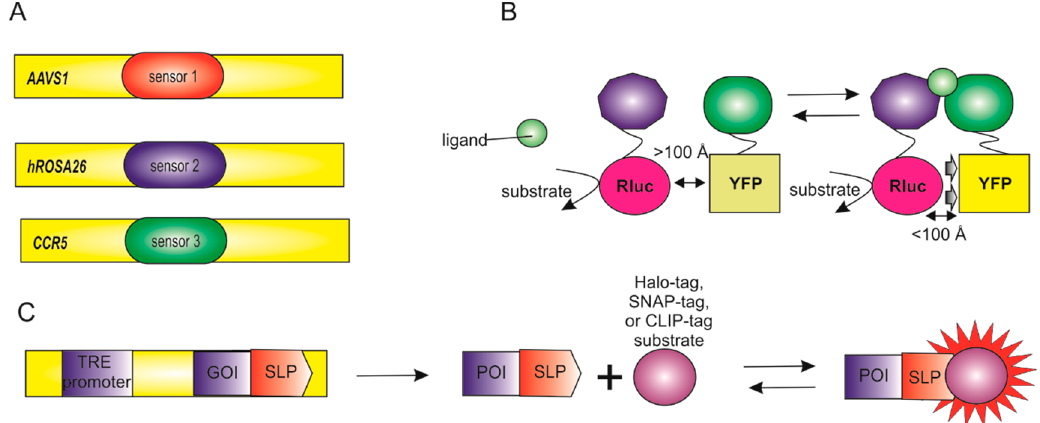
Figure 4. Combination of biosensors. ( A ) Combination of several biosensors at different safe-harbor loci. ( B ) Combination of different biosensors types, for example, chemiluminescent protein and the fluorescent protein. BRET. ( C ) Combination of organic dyes and a genetically encoded protein. SNAP-tag, Halo-tag, and CLIP-tag are composed of a small protein that mediates the covalent binding between the genetically encoded target and the